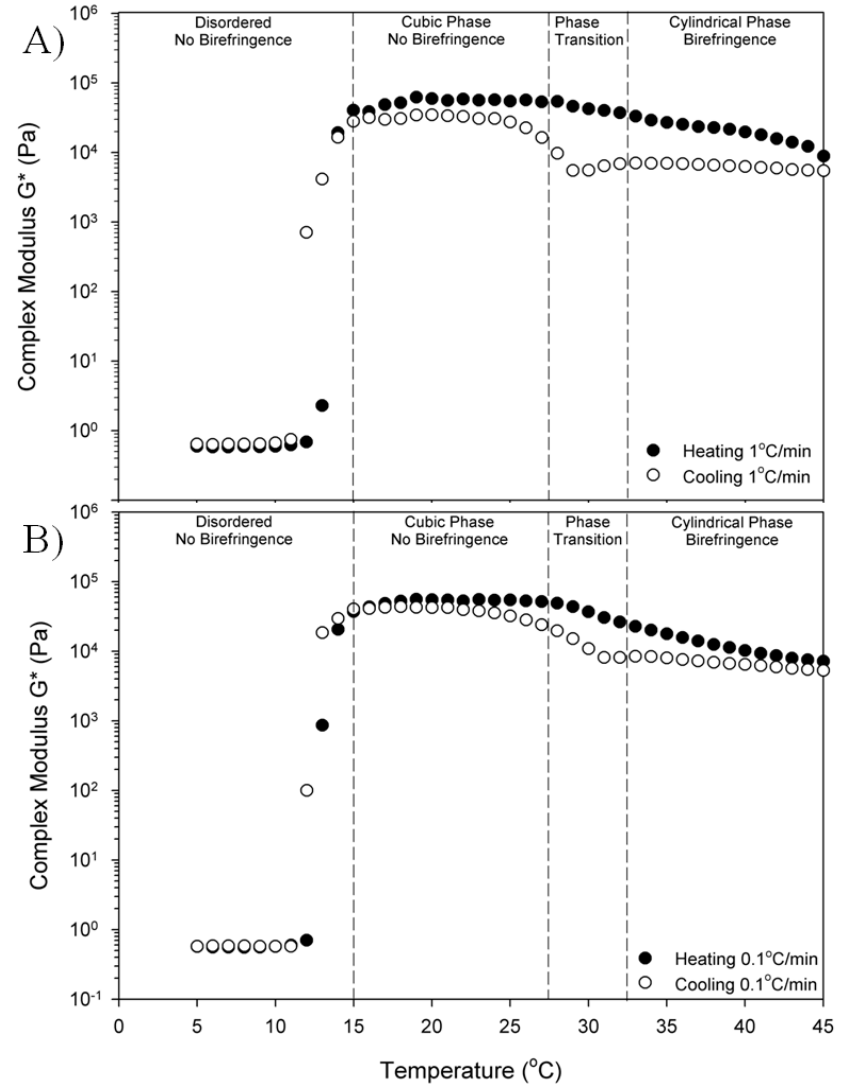
Figure 3. Complex modulus (ω = 1 rad/s, σ ordered phase) 35 wt% block copolymer during temperature ramps of ( A ) 1°C/min and ( B ) 0.1 °C/min. Phase designations and observations from Figure